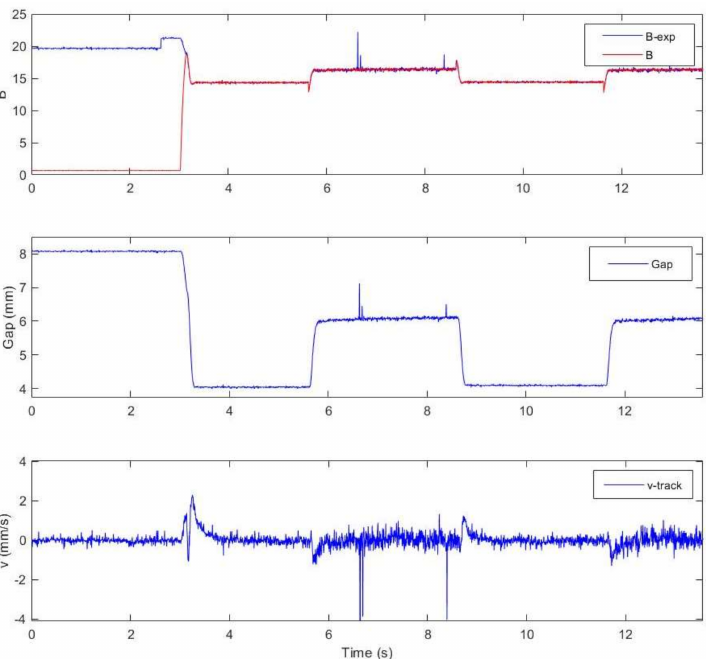
Figure 15. The magnetic flux, suspension gap, and vertical track velocity under the rigid track